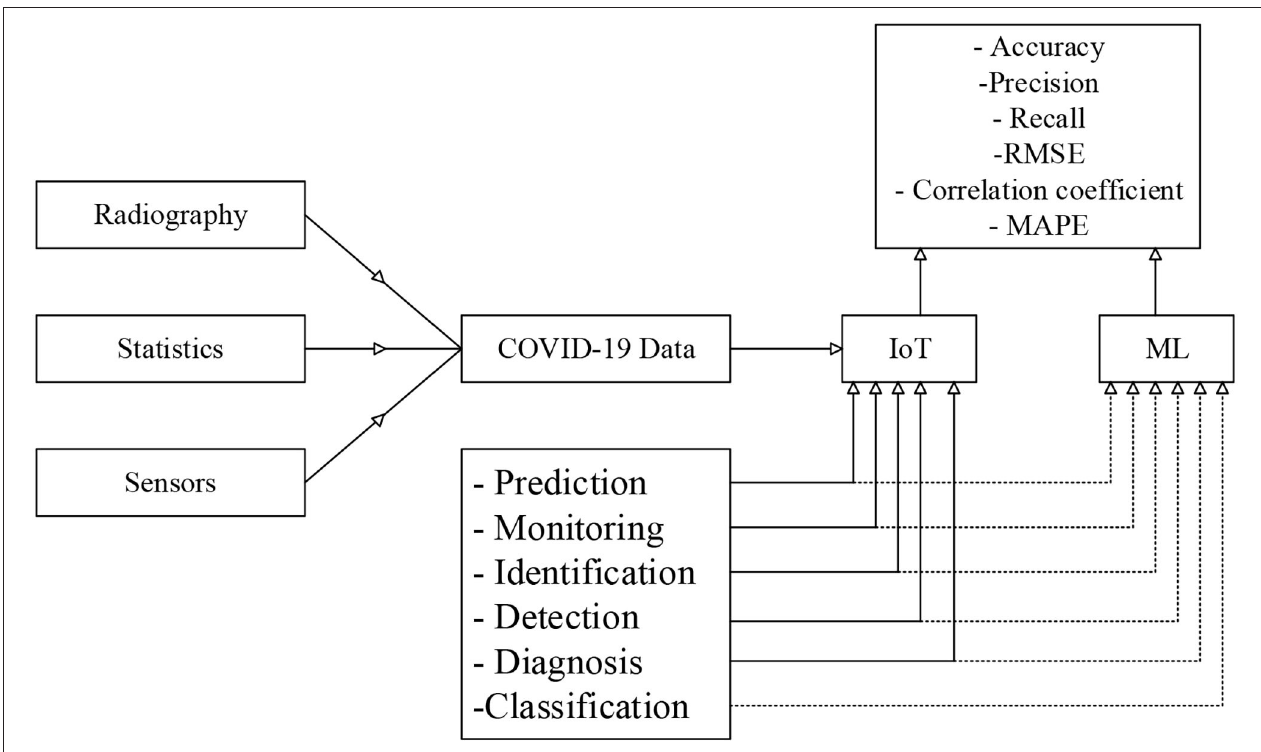
FIGURE 3 | Main contributions of the current study.